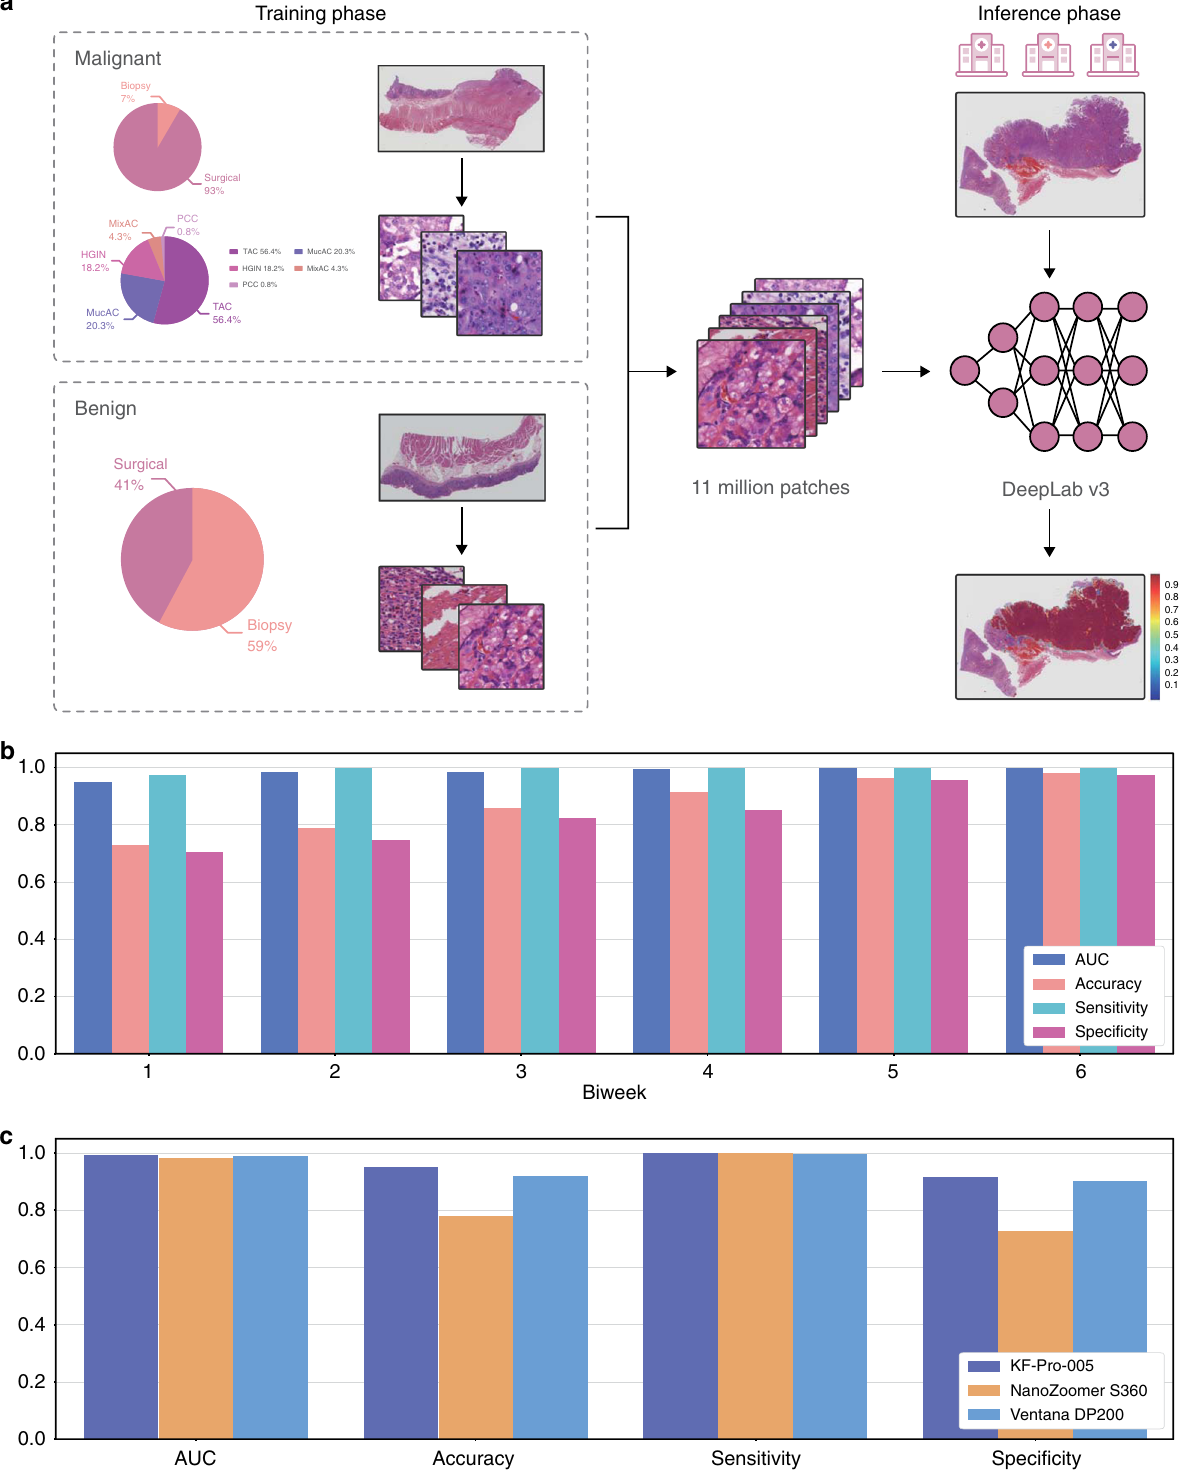
Fig. 1 The framework of our research and model performance on the daily gastric dataset. a Deep learning model training and inference. We trained the model using WSIs digitalized and annotated at PLAGH. We illustrated the training data distribution at the slide level. The abbreviations are detailed in Supplementary Table 1. The trained model was tested by slides collected from PLAGH and two other hospitals. b The plot of the model performance histogram of the slides from the daily gastric dataset. c Model performance histogram of the daily gastric slides digitalized by three different